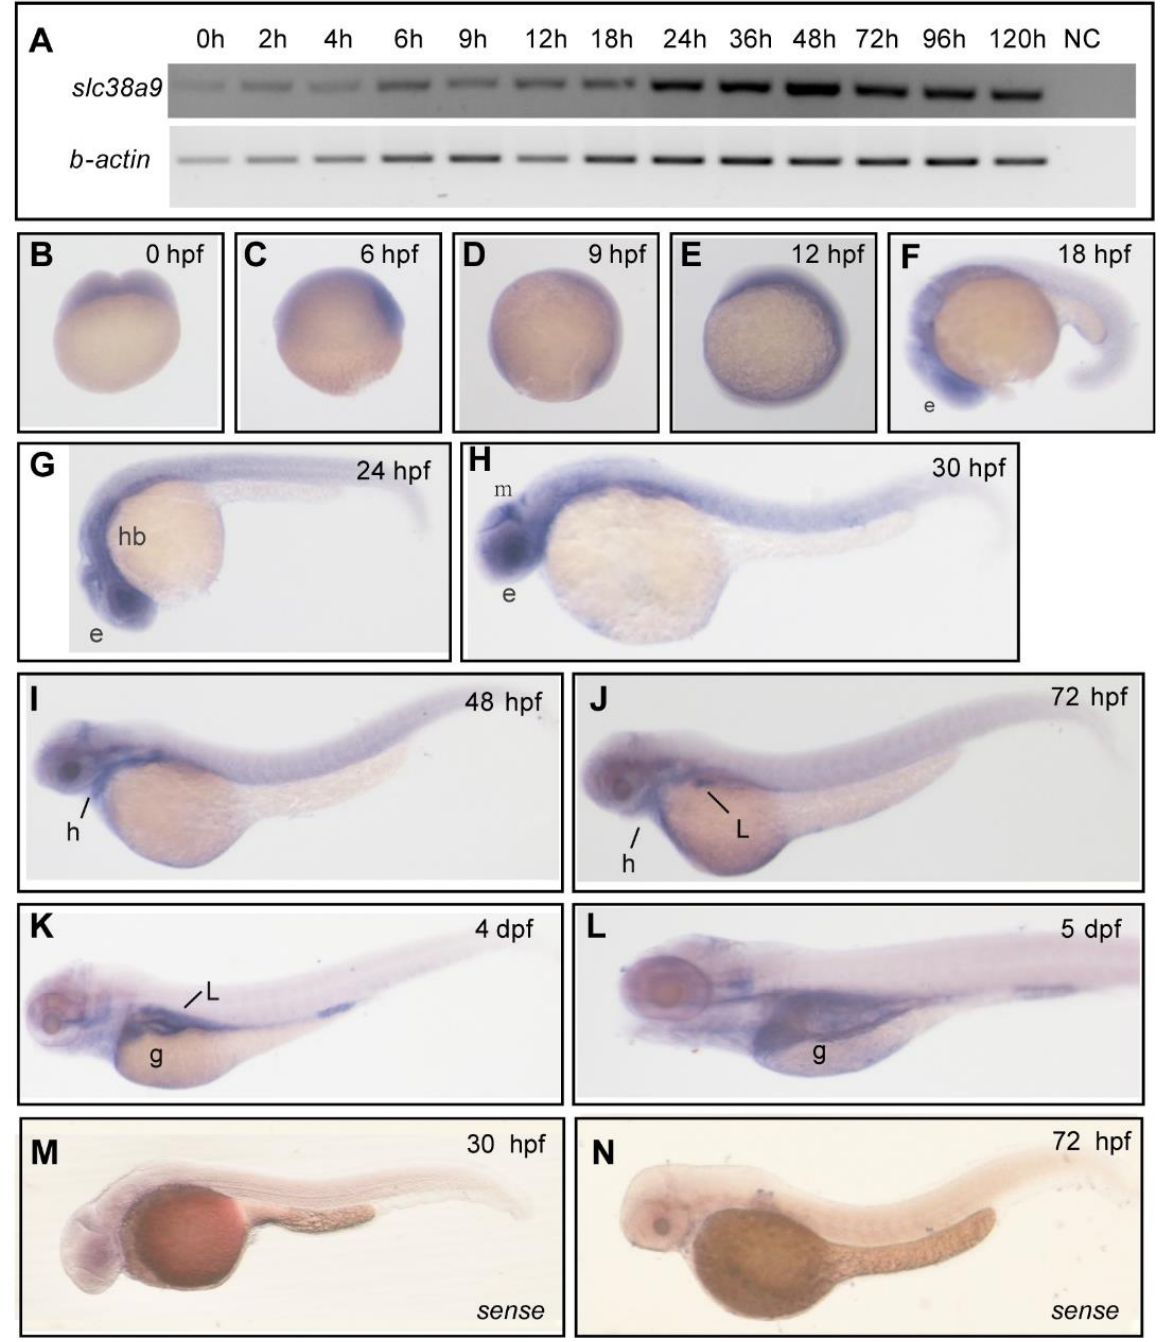
Figure 1. Spatiotemporal expression pattern of slc38a9 in zebrafish. ( A ) RT-PCR analysis of zebrafish slc38a9 mRNA at the indicated embryonic stages. Numbers indicate different developmental stages as hours post-fertilization. NC, negative control. β -actin as the internal control. ( B – L ) Wholemount in situ hybridization (WISH) reveals the slc38a9 mRNA expression pattern in the zebrafish embryos at the indicated embryonic stages. slc38a9 expression is ubiquitous from the one-cell stage to 12 hpf ( B – E ), restricted to the retina at 18 ( F ), 24 ( G ), and 30 hpf ( H ). The slc38a9 expression encompasses the heart and midbrain region at 30 ( H ) and 48 hpf ( I ). From 72 hpf to 5 dpf, the slc38a9 expression is restricted to the liver and gut ( J , L ). ( M , N ) Views of zebrafish embryos hybridized with sense zebrafish slc38a9 probe. Abbreviations: e, eye, mb, midbrain; g, gut; hb, hindbrain; l, liver; h,